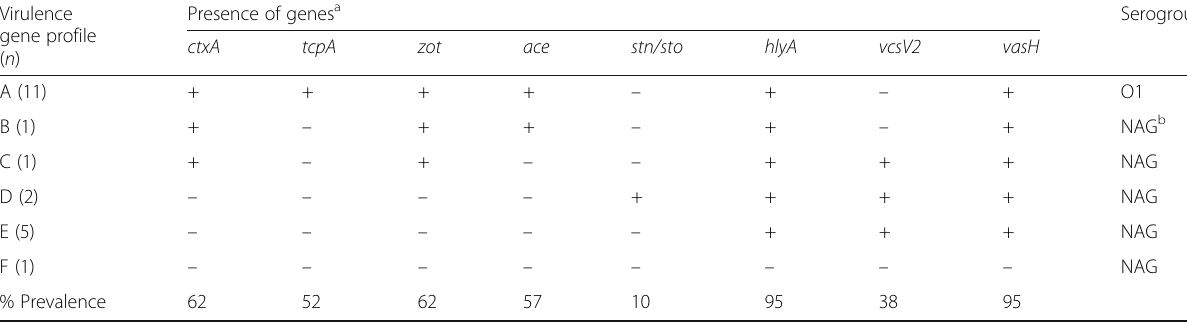
Table 3 Distribution of virulence-associated genes among V. cholerae isolates Virulence gene